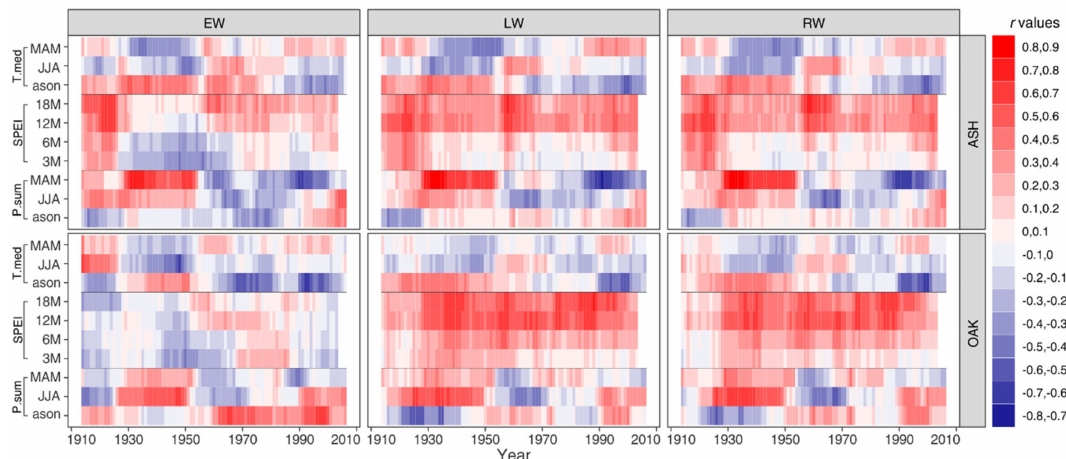
Figure 6. Twenty-five-year moving correlation analysis between main climatic drivers and tree-ring